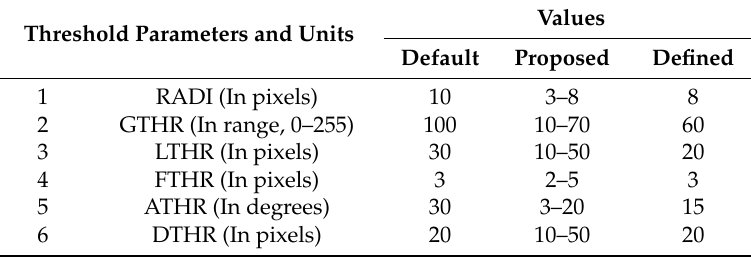
Table 2. The values used for the parameters of the LINE